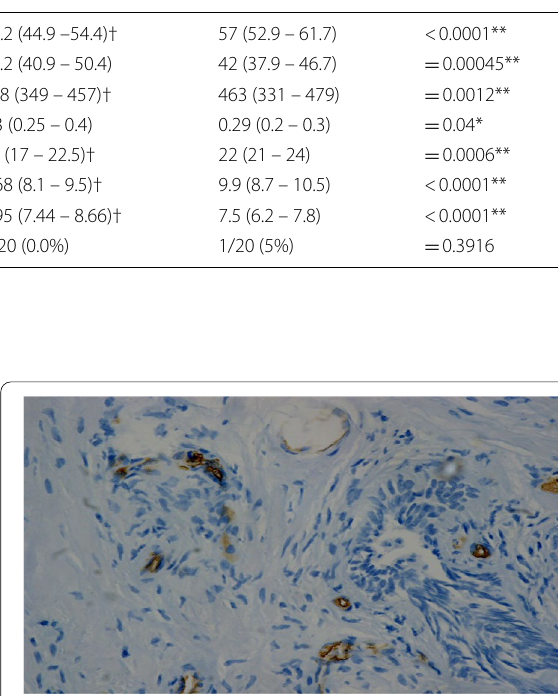
Fig. 2 CD34 staining of prostatic tissue in a patient in finasteride group: showing decrease in microvessel